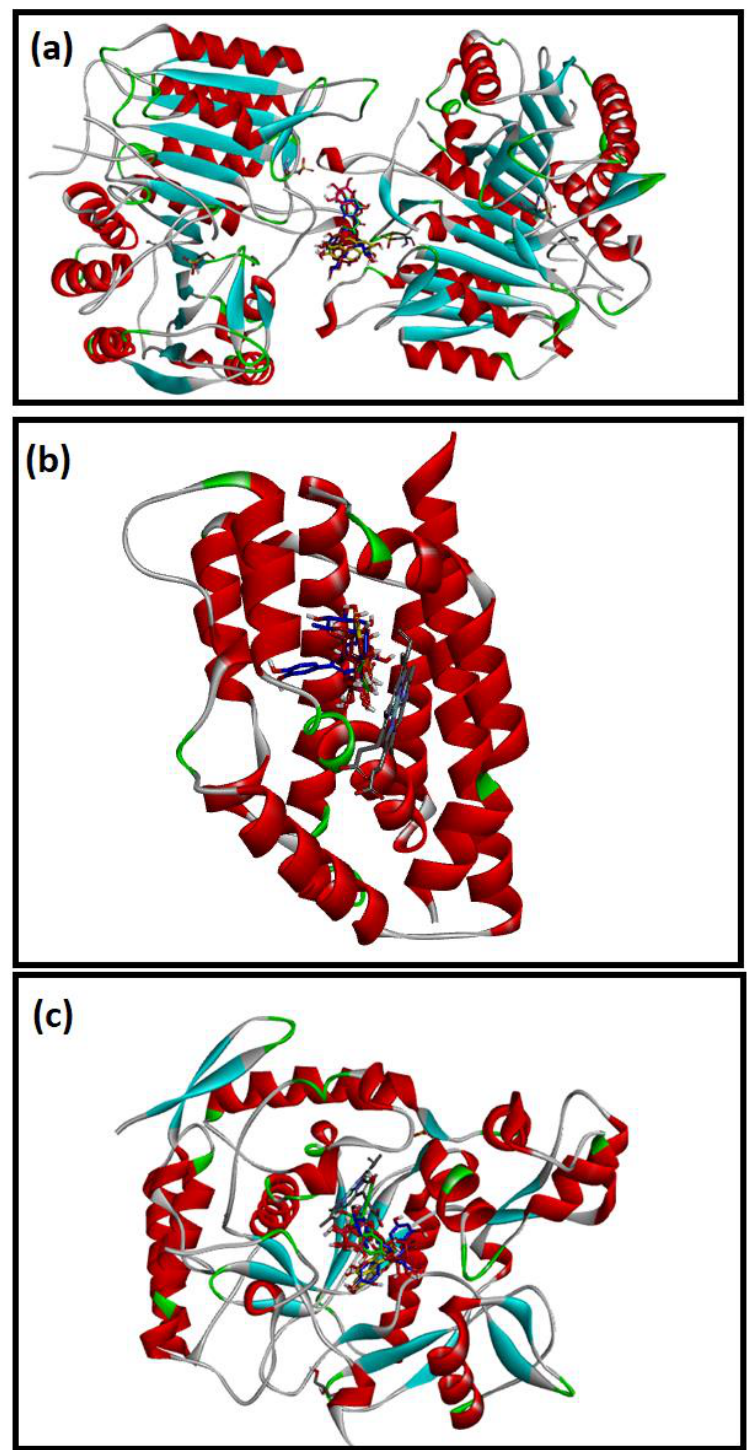
Figure 11. Overlay of docked rutin (blue), catechin (green), chlorogenic acid (red), ellagic acid (yellow), methyl gallate (pink), and gallic acid (orange) into ( a ) the caspase-3 protein (Code: 3DEI), ( b ) HO-1 (Code: 3CZY), and ( c ) iNOS (Code: 1NSI).